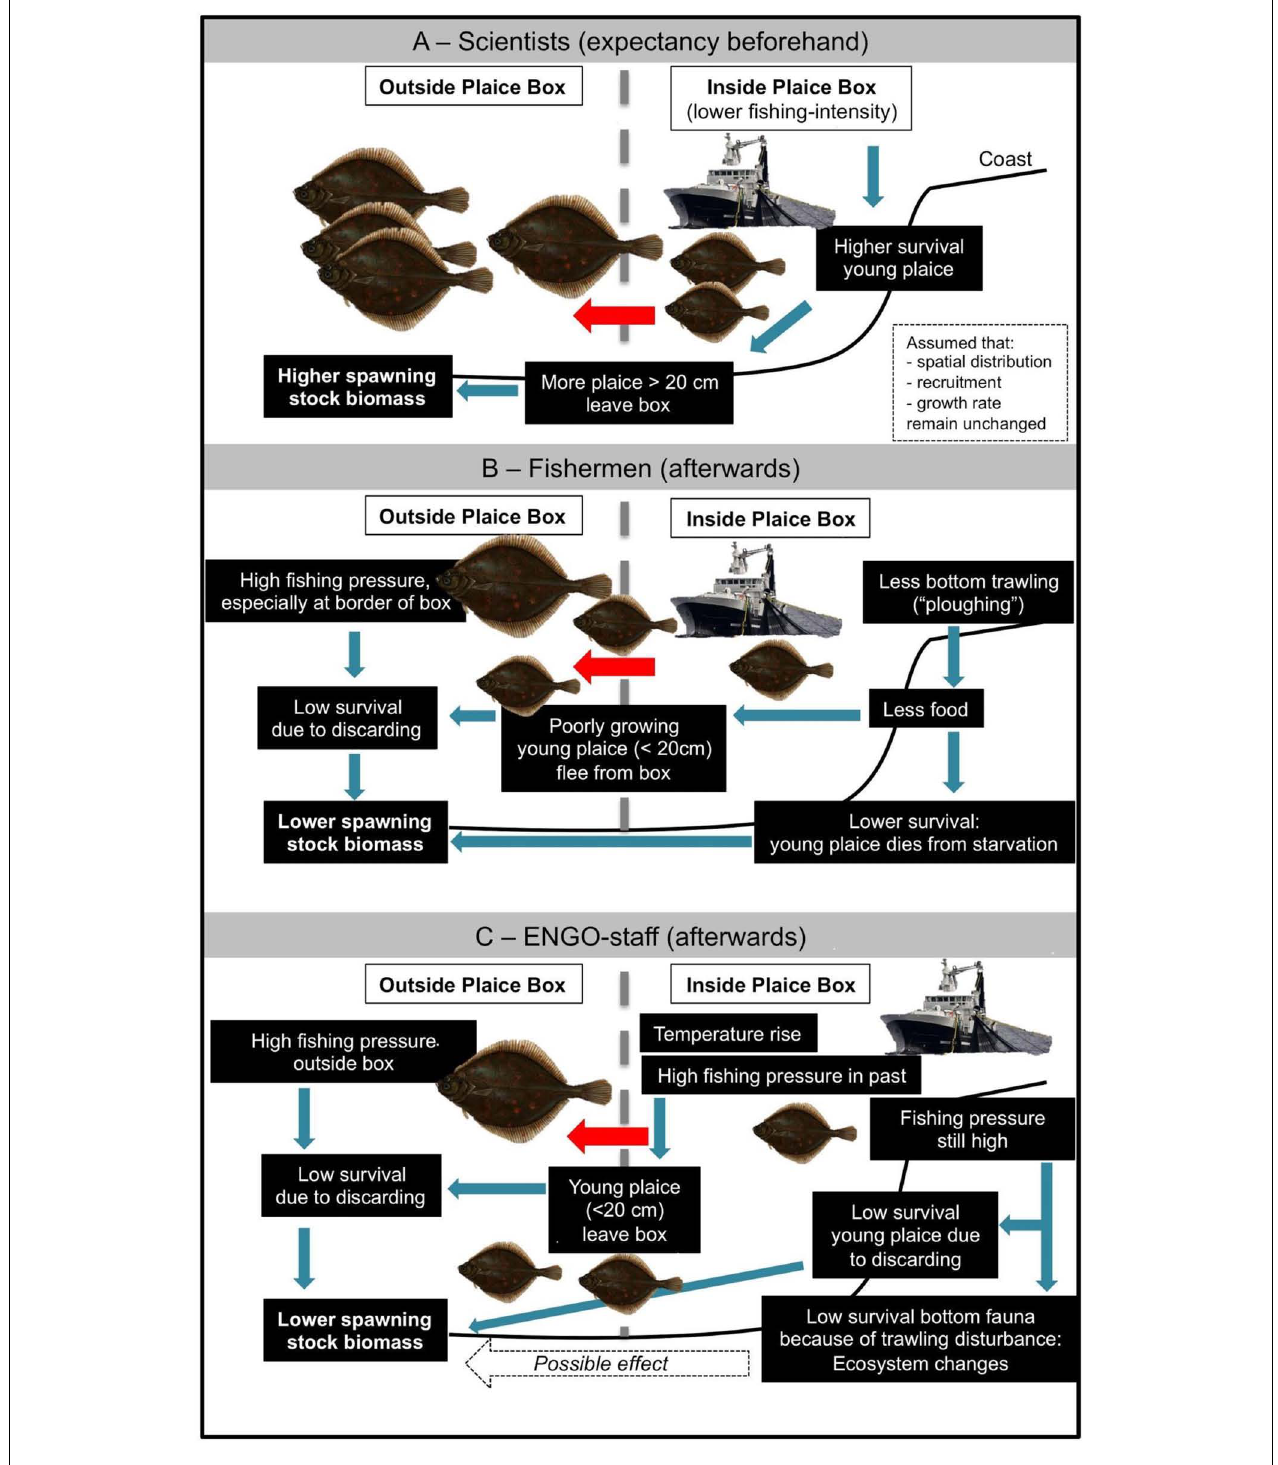
FIGURE 6 | Different perceptions about the plaice box. (A) The reasoning and communication by scientists at the time the box was implemented. (B,C) The functioning of the plaice box according to fishermen and environmental NGOs, respectively (modified from Beare et al., 2010).